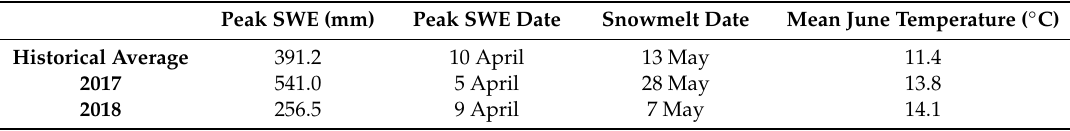
Table 1. Butte Snow Telemetry (SNOTEL) data in 2017 and 2018 compared to the historical average (1986–2017).